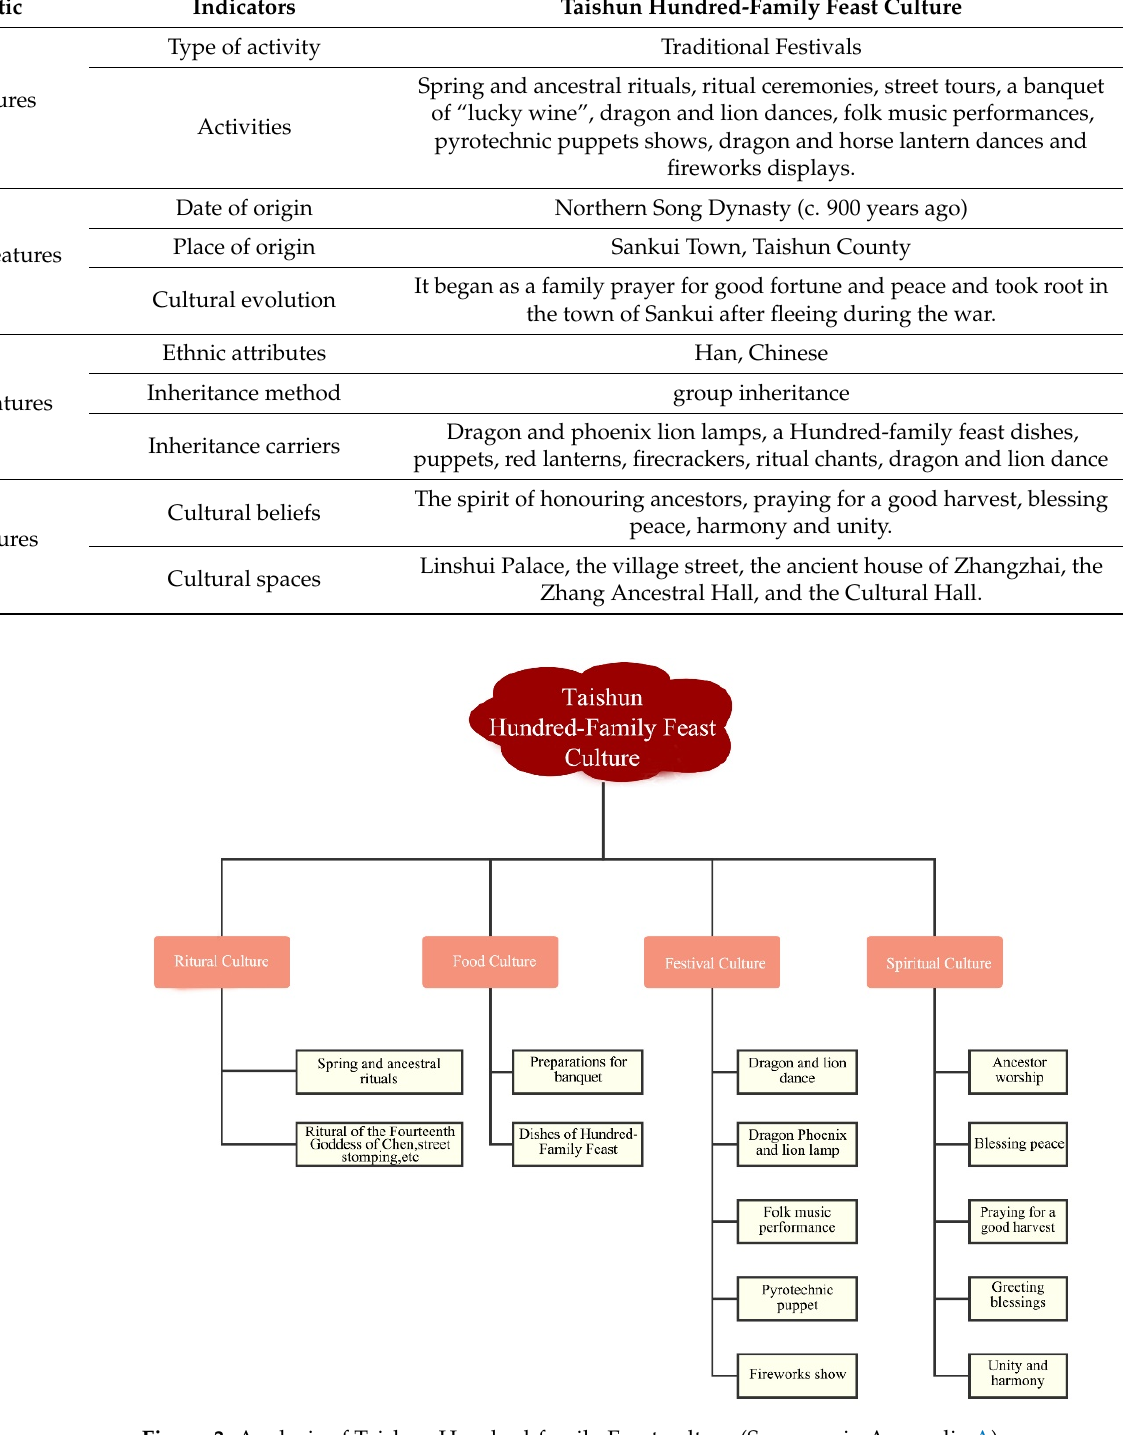
Figure 3. Analysis of Taishun Hundred-family Feast culture (See more in Appendix